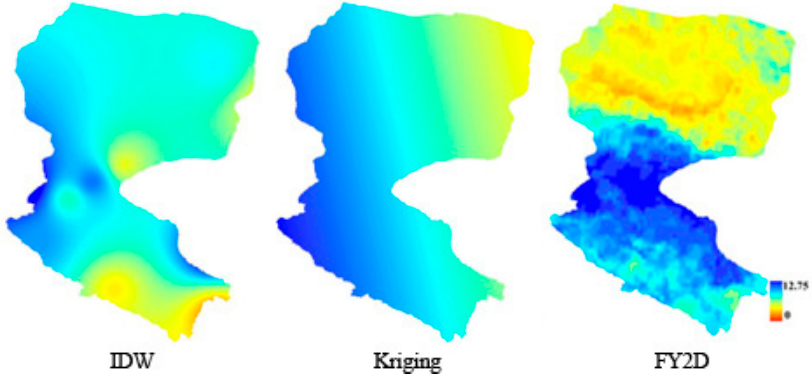
Figure 3. Spatial distribution of sunshine duration distribution estimated by IDW ( left ), Kriging ( middle ), and the proposed model ( right ) over the Heihe River Basin on 16 July 2008.